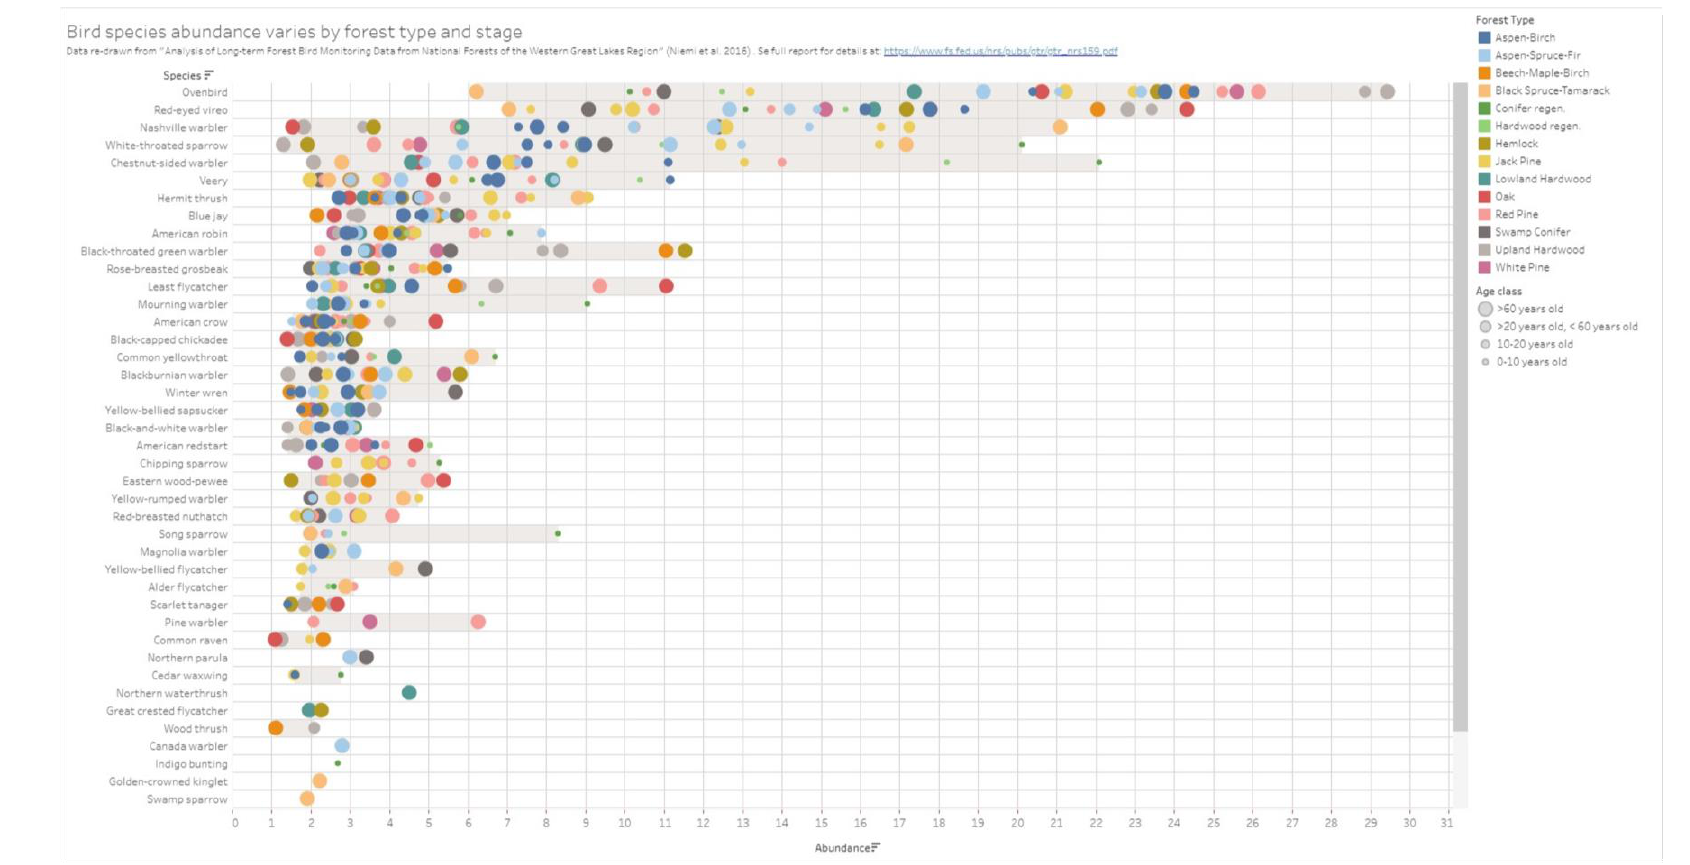
Figure 12. Variation in bird abundances by forest type/stage combinations as reported by Niemi et al. (2016) [114]. Dot colors represent forest type (see legend). Dot size represents stand age (see Legend). Horizontal lines that connect dots for each species represent the full range of abundances that were observed for each species across all forest type/stage combinations. An interactive version of this graph is available at: https://public.tableau.com/app/profile/casey.lott/viz/ForestbirdhabitatassociationsinGreatLakesNationalForests/Sheet1 (accessed on 6 February 2021), https://www.fs.fed.us/nrs/pubs/gtr/gtr_nrs159.pdf (accessed on 6 February